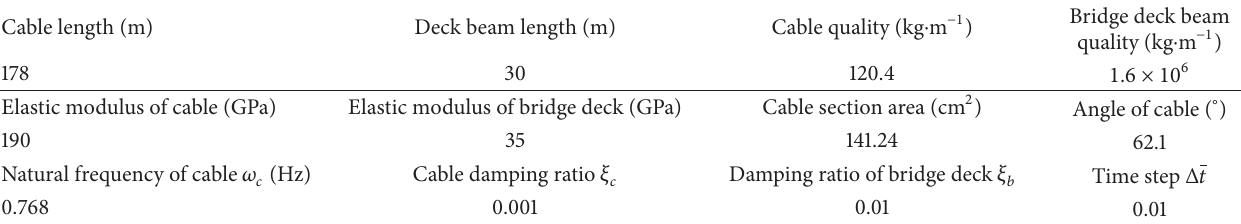
Table 1: Parameter of cables and bridge deck